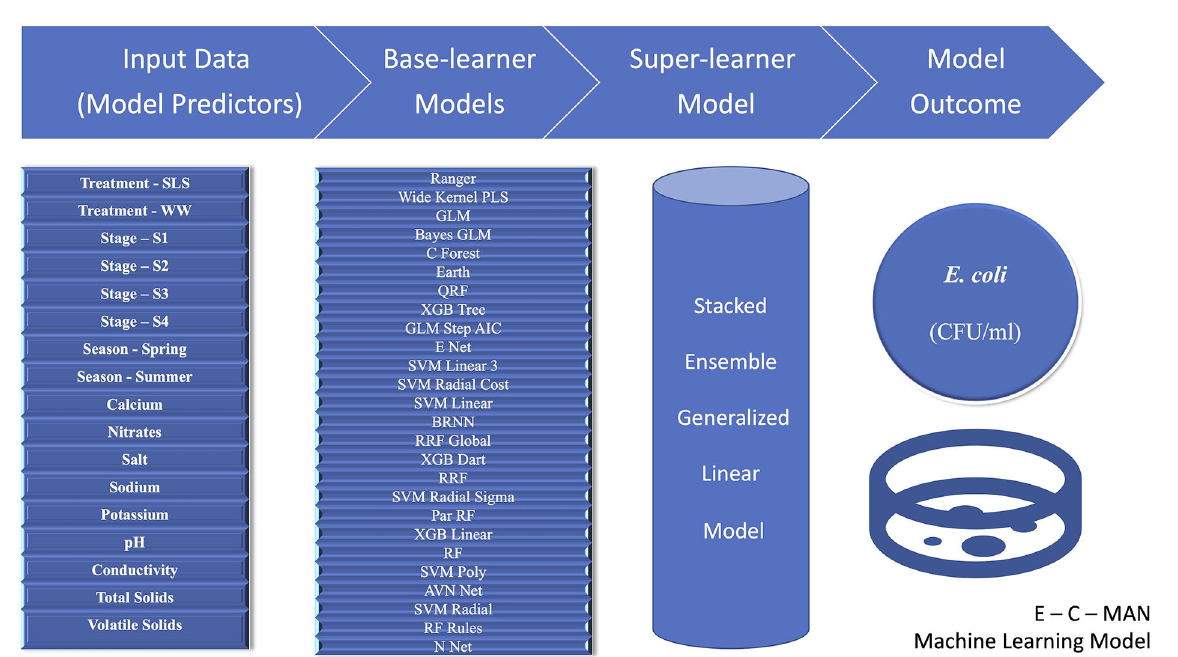
FIGURE5 Visual representation of the E-C-MAN stacked ensemble Generalized Linear Model that was built using 17 chemical, physical, structural, and seasonal input variables to predict Escherichia coli levels (Colony Forming Units per milliliter, CFU/ml) in Dairy Effluent Management Systems that utilized either the gravitational Weeping Wall (WW) or the mechanical Solid-Liquid Separator (SLS) systems. The E-C-MAN model comprised of 26 base-learner regression models, whose individual outputs were stacked in a Generalized Linear Ensemble Model to predict E. coli levels.